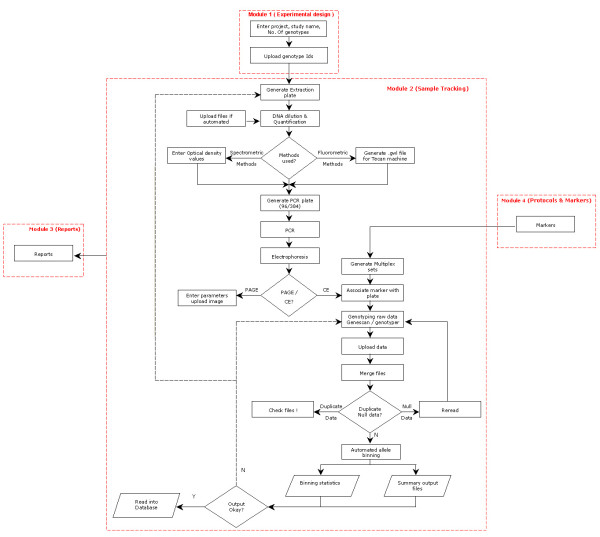
LIMS modules and information flow. Dotted rectangles indicate the four LIMS modules. Rectangles indicate processes in the data flow chart, diamond indicates decision, and parallelogram indicates data storage steps. (PCR: Polymerase Chain Reaction, PAGE: Polyacrylamide Gel Electrophoresis, CE: Capillary Electrophoresis)